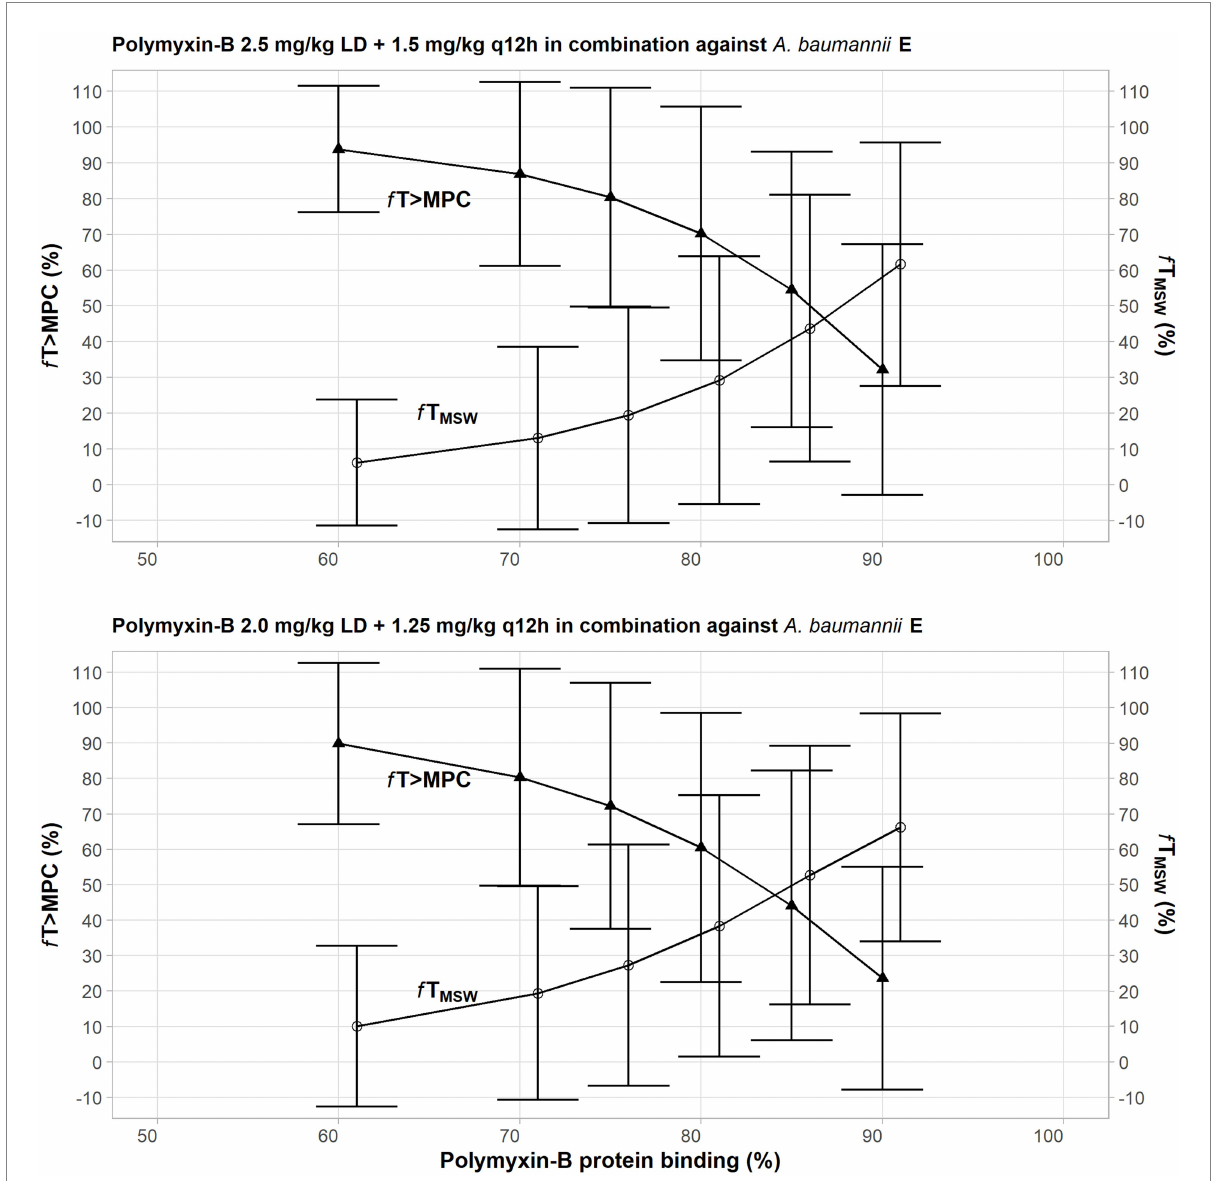
FIGURE 3 Sensitivity analysis to evaluate effect of variability in polymyxin plasma protein binding on the pharmacodynamic parameters f T MSW and f T >MPC after polymyxin dosing regimens in combination therapy consisting of 2.5 mg/kg loading dose followed by 1.5 mg/kg q12h at 12 h (top graph) and 2 mg/ kg loading dose followed by 1.25 mg/kg q12h at 12 h (bottom graph) against A. baumannii E. The models assumed polymyxin MIC of 1 mg/l and MPC of 4 mg/l, whereas meropenem MIC and MPC were both 4 mg/l with or without 4 mg/l sulbactam. In this scenario, the proposed dosing regimens of both meropenem and sulbactam can achieve PTA ≥